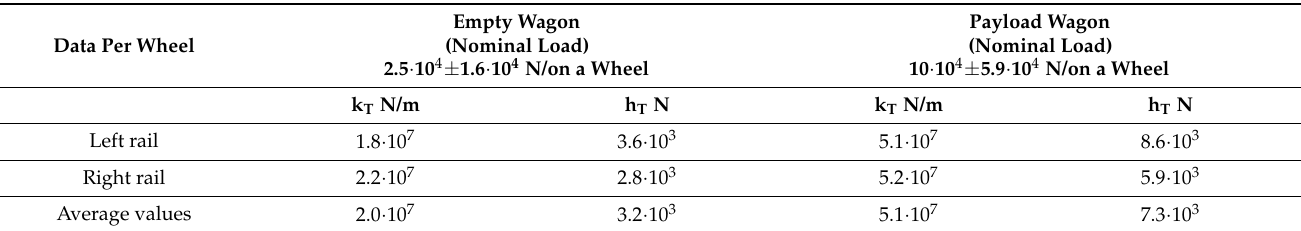
Table 5. Coefficients k T and h T .